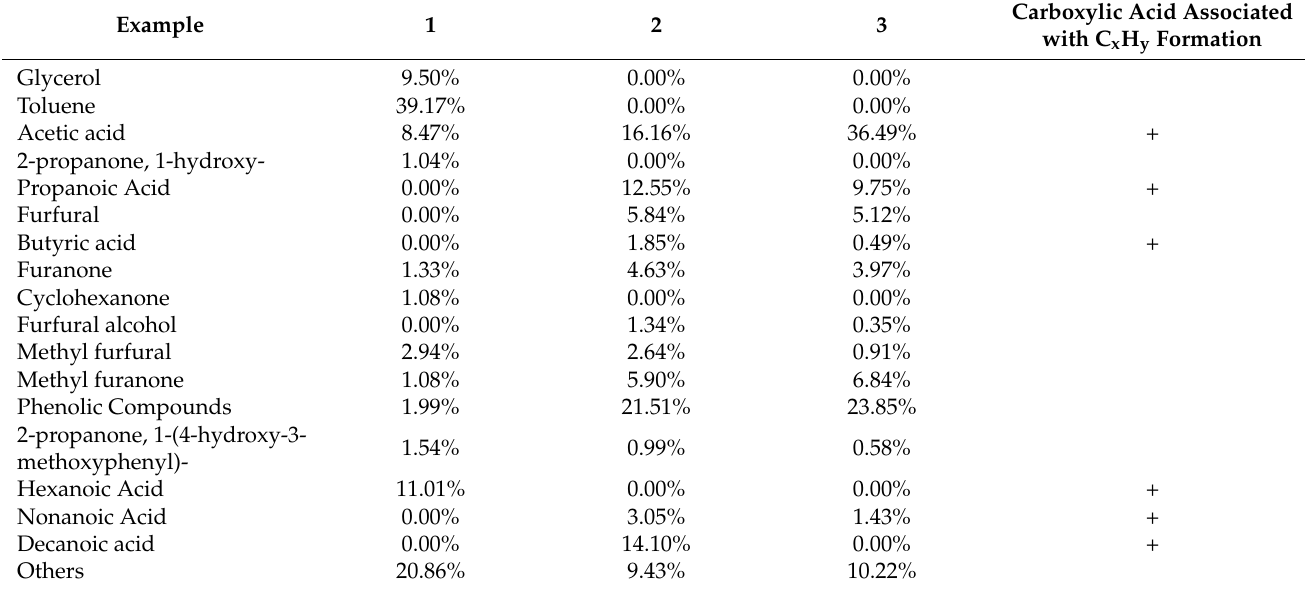
Table 1. Example carbonization liquid [CL] (organic molar) composition from a carbonization reactor processing municipal waste (wood, plant waste, plastics, paper, carboard, organic waste). Organics represent between 10 and 50% of the molar wastewater [CL]